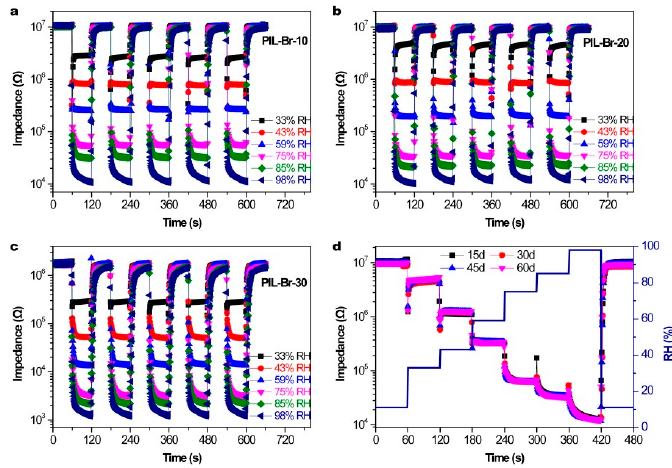
Figure 5. The repeatability characteristic of PIL-Br sensors from 11% to 98% RH: ( a ) PIL-Br-10, ( b ) PIL-Br-20 and ( c ) PIL-Br-30, respectively, ( d ) Long-term stability of a PIL-Br-10 humidity sensor.